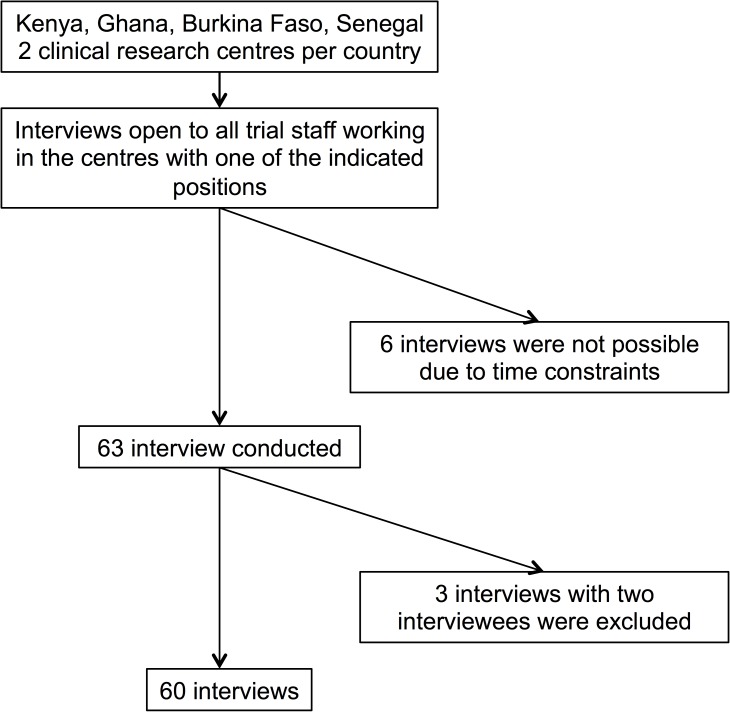
Sampling procedure.